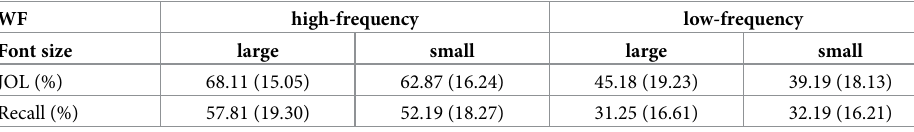
Note. JOL = judgment of learning; WF = word